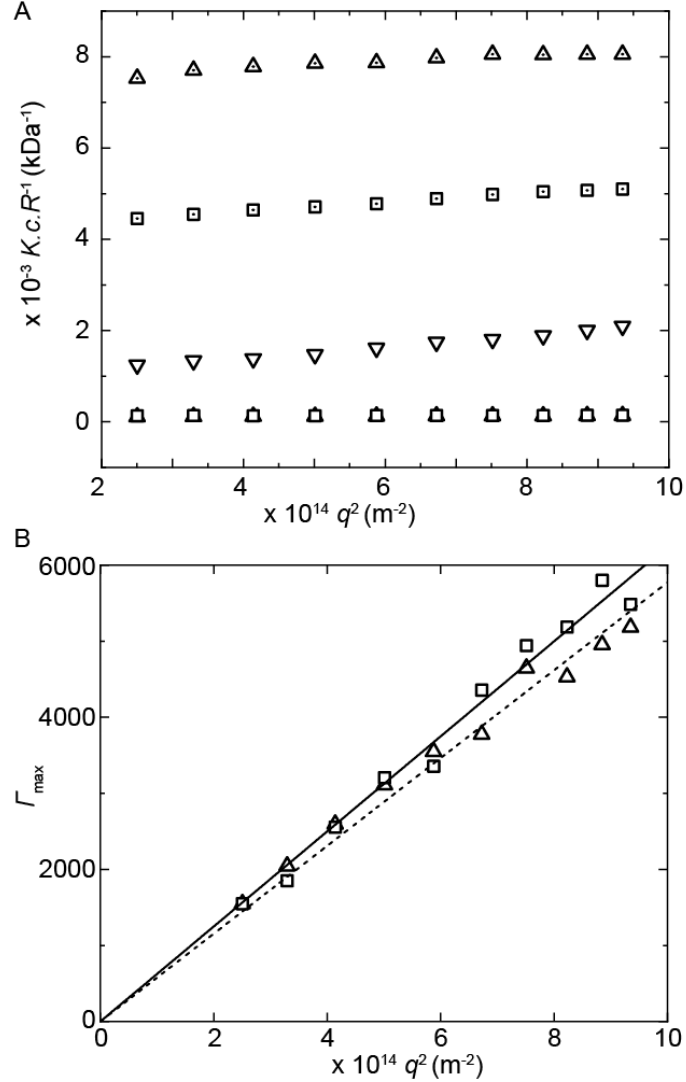
Figure 2. ( A ) Partial Zimm plot of separate constituents and PUI:PMVP 29 - b -PEO 204 complexes constructed to compare the Rayleigh ratio, R (q), and to obtain M complex and R g for PUI:PMVP 29 - b -PEO 204 from the linear fits (not shown). ( B ) Mean frequency Γ from multi-angle dynamic light scattering (DLS) vs. q 2 for PUI:PMVP 29 - b -PEO 204 complexes; lines represent linear fits. PUI-A2 at ϕ THF = 0.1 in water (dotted square), PUI-S2 at ϕ THF = 0.1 in water (dotted triangle), PMVP 29 - b -PEO 204 at ϕ THF = 0.1 in 10 mM NaNO 3 (downwards pointed triangle), and mixtures of PUI-A2 :PMVP 29 - b - PEO 204 (square) and PUI-S2 :PMVP 29 - b -PEO 204 (triangle) at ϕ THF = 0.1 in 10 mM NaNO 3 with a total polymer concentration of 10